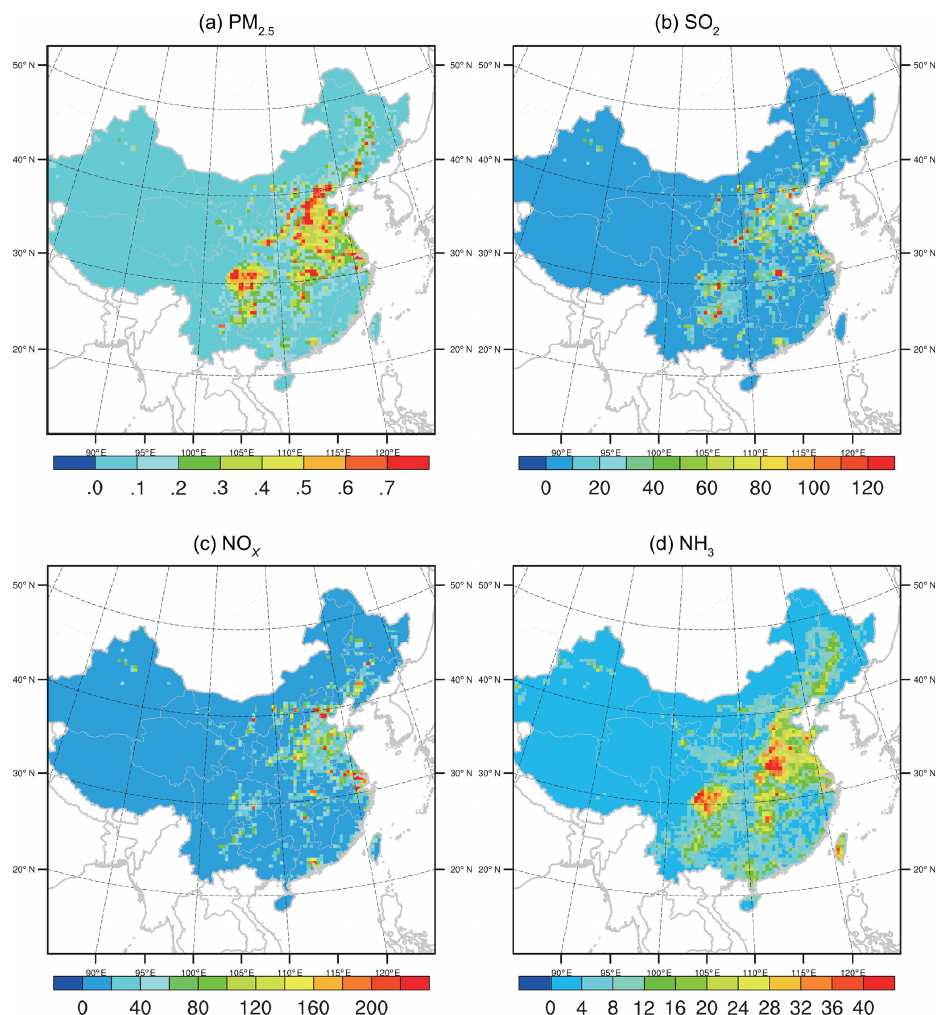
Figure 2. Spatial distribution of primary PM 2 . 5 ( a ; the sum of BC, OC, sulfate, nitrate and other unspecified PM 2 . 5 emissions), SO 2 (b) , NO x (c) and NH 3 (d) emissions (units are µgm − 2 s − 1 for PM 2 . 5 and molkm − 2 h − 1 for the other three) used in this